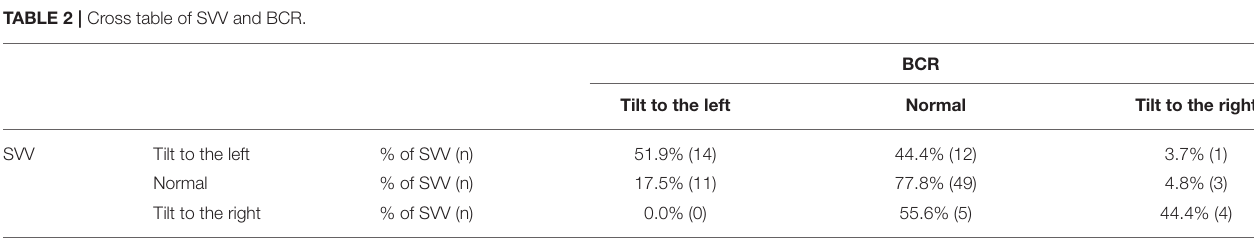
FIGURE 4 | Congruency between SVV and oVEMP (upper panel, patients with normal SVV; middle panel, patients with pathologic SVV; lower panel, difference). Groups of patients are age-matched. For each patient, a congruency value for oVEMP was assigned. Congruency value in patients with normal SVV: 0, oVEMP normal; 1, oVEMP tilted to the right; − 1, oVEMP tilted to the left. Congruency value in patients with pathologic SVV: 0, oVEMP normal; 1, oVEMP congruent with pathological SVV; − 1, oVEMP not congruent with pathological SVV. Frequency distributions of means were obtained by bootstrapping. oVEMP, ocular vestibular evoked myogenic potential; SVV, subjective visual vertical.